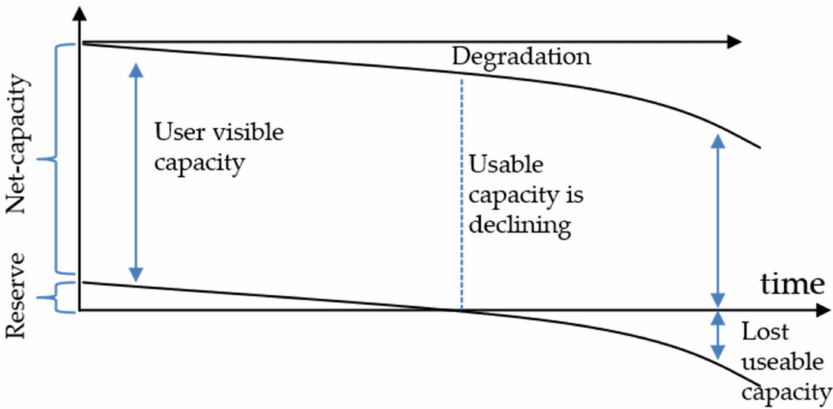
Figure 13. User visible capacity from battery management system, reserve is not shown to the user but the state-of-health remains 100% even though degradation already